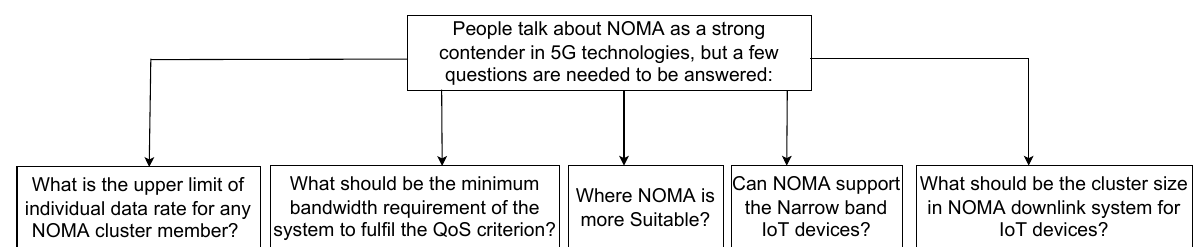
Figure 1. Motivation behind proposed